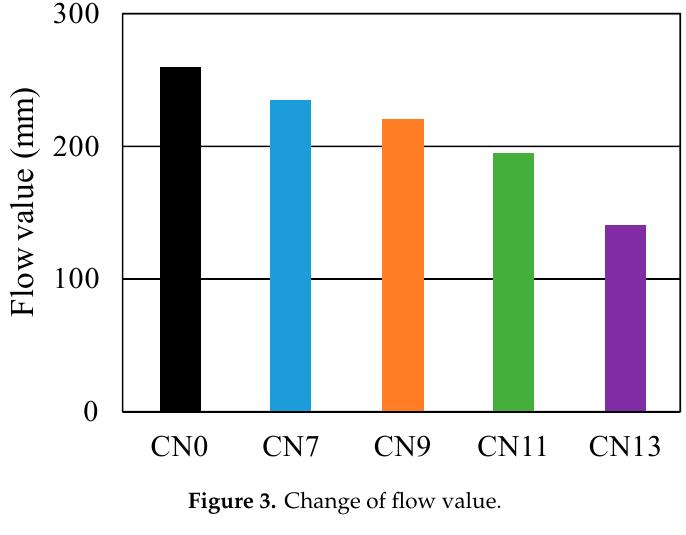
Figure 3. Change of flow value.